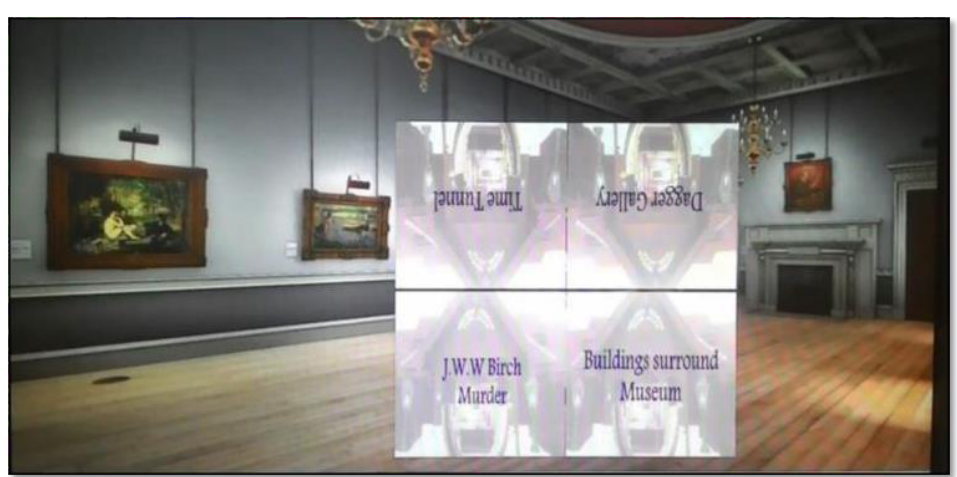
Figure 3. A top view of the Pasir Salak Museum interface as used in the preliminary study.